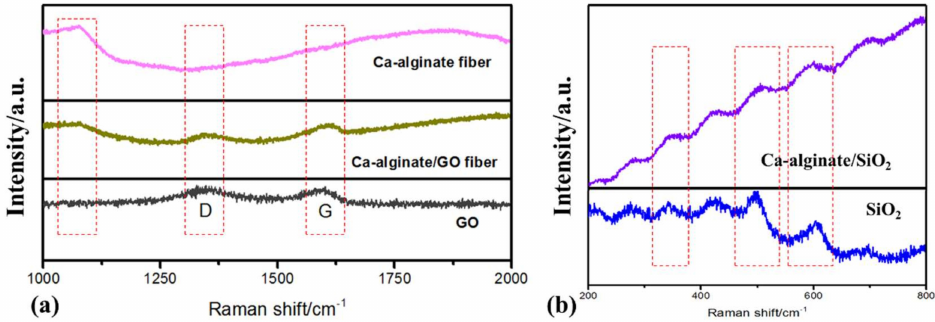
Figure 3. Raman test of the three kinds of fibers: ( a ) Ca–alginate fiber and Ca–alginate / GO fiber; ( b ) Ca–alginate / SiO 2